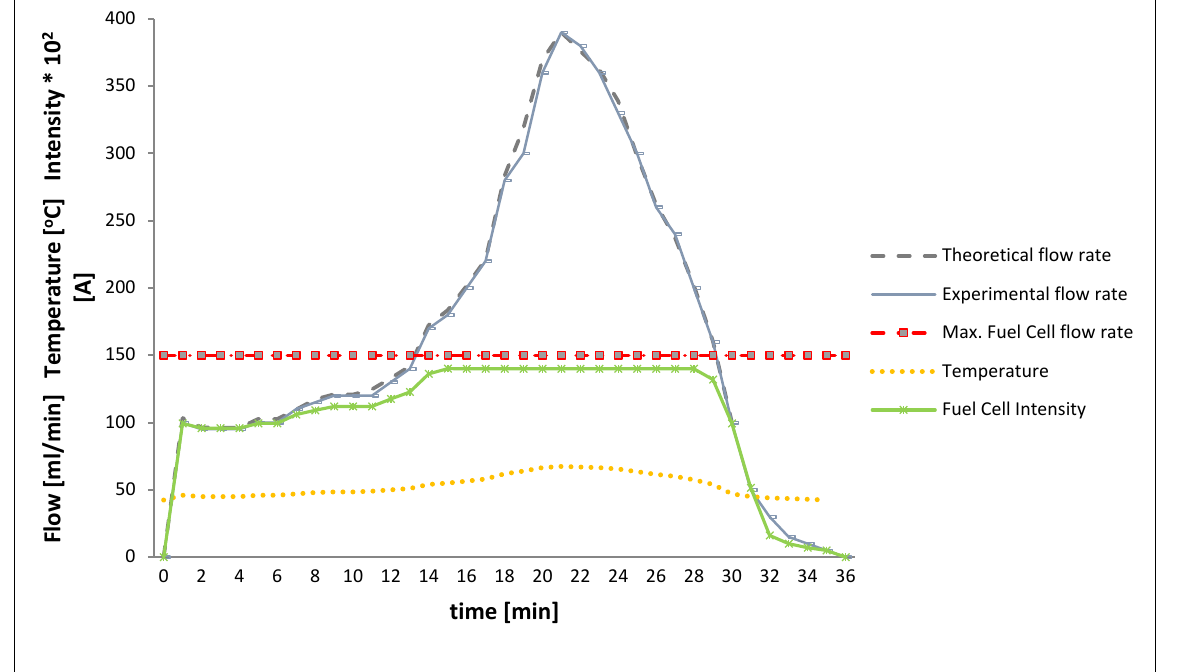
Figure 6. Theoretical hydrogen flow comparison of Q (H2, t) produced from 15 rings and those obtained in the vehicle tank under the test conditions. The intensity generated by the fuel cell during the test is also shown.